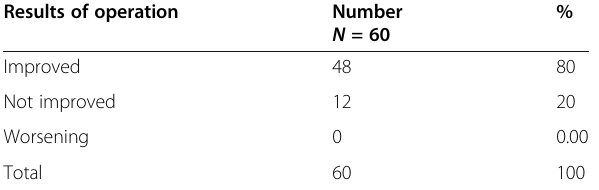
Table 9 The operation results of patient with non-nasal